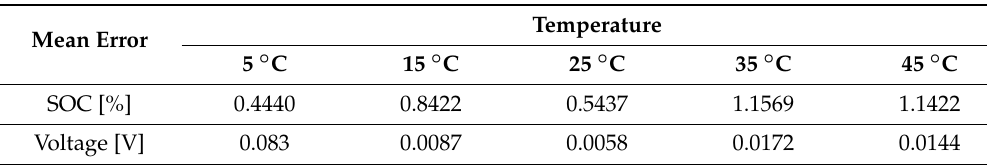
Table 4. SOC and voltage mean estimnation errors.